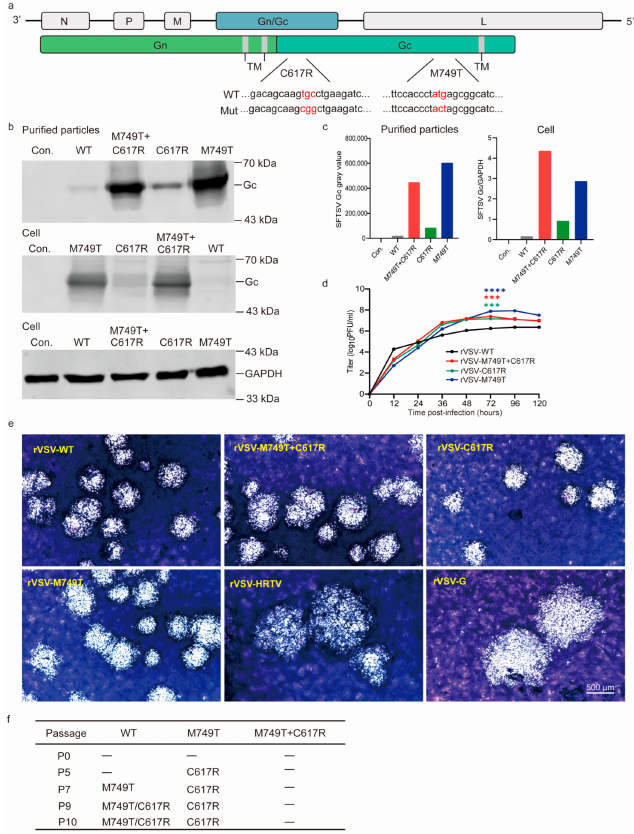
Figure 1. Characterization of rVSV-SFTSV variants. ( a ) Schematic of the mutations that emerged in the SFTSV Gc protein. Mutation (Mut). Mutated nucleotides (Red) ( b ) Gc expression in the supernatants and cell lysates of rVSV-SFTSV WT- and variant-infected Vero cells (MOI = 0.01). Forty-eight hours post-infection, purified particles and cell lysates were blotted with anti-SFTSV Gc polyclonal antibodies (GAPDH as control). Con. indicates mock-infected cells. ( c ) Quantification of ( b ). ( d ) Growth kinetics of rVSVs (MOI = 0.01). *** t test, p < 0.001; **** t test, p < 0.0001. ( e ) Representative image of plaques formed using rVSV-SFTSV variants (6 days), rVSV-HRTV (6 days), and rVSV-G (3 days) at indicated days post-infection in Vero cells. Scale bar: 500 µ m. ( f ) Genetic stability of rVSV-WT and rVSV-M749T + C617R during passages (P) in Vero cells. The above data are representative of three independent